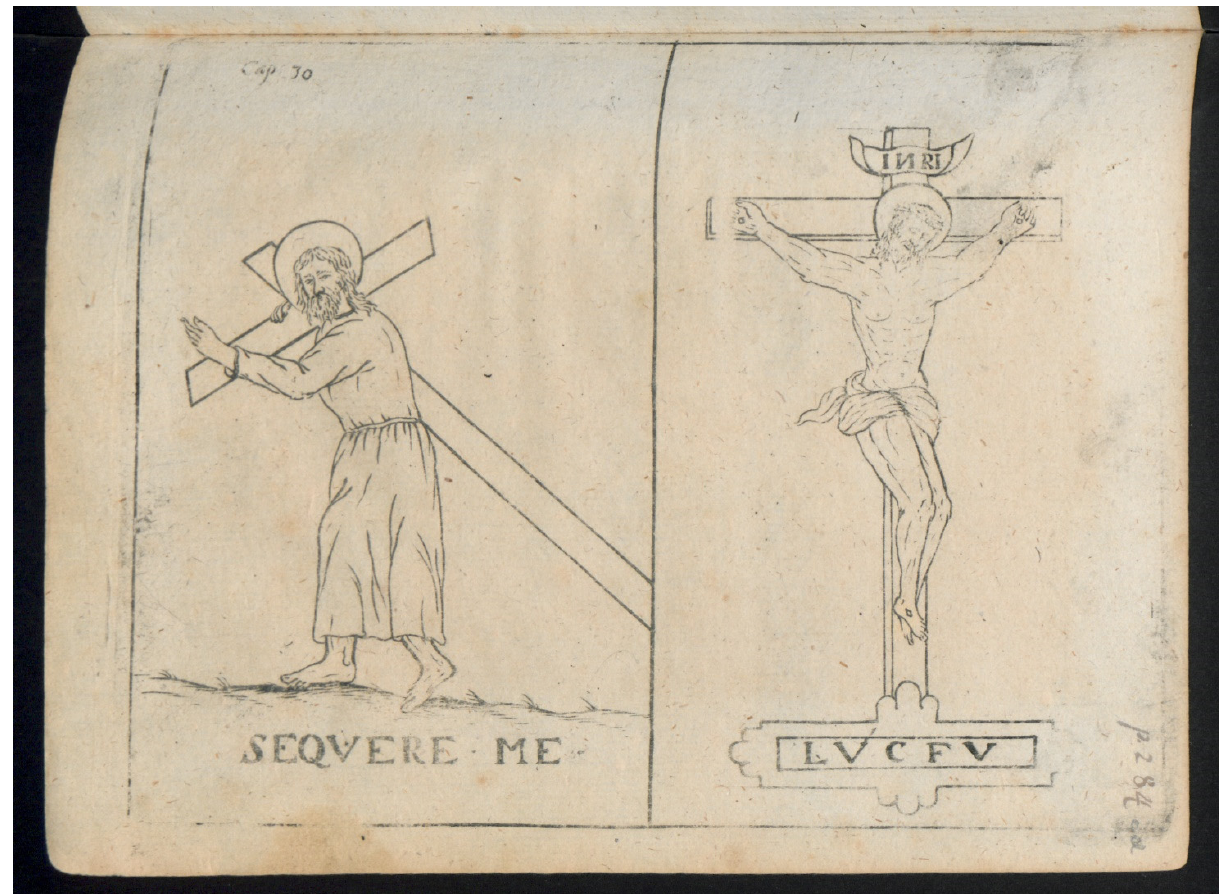
Figure 8. Examples of pilgrim tatoos. Illustration from Otto Friedrich Gröben, Orientalische Reise- eschreibung/Des Brandenburgischen Adelichen [...], 1694. eschreibung/Des Brandenburgischen Adelichen [...],